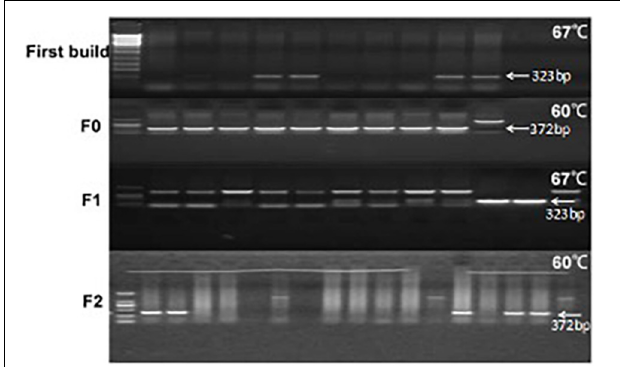
FIGURE 2 | Agarose electrophoresis analysis of PCR amplification products of the galectin-7-encoding gene in the mouse of different generations of TG mice at different annealing temperatures. Each lane was loaded with 5 µ l of PCR products. This is a combination diagram of agarose gel electrophoresis reactions of different individual mice, where F0, F1, and F2 represent the algebra of different mice. In the agarose gel electrophoresis figure, from left to right, the first lane on the left is a marker (DL2000-DNA-marker, with sizes of 100, 250, 500, 750, 1,000, and 2,000 bp, respectively. Second, each lane represents an individual. First built mice 12 mice, F0 has 12 mice, F1 has 10 mice, and F2 had 15 mice. Each individual uses two sets of different primers for PCR amplification, the product sizes are 323 bp and 372 bp, respectively, and the reaction system was 25 µ l as described in the method. When the first band is unclear or the band is too shallow, it uses the second set of primers to detect coincidence. The positive control is the galactin-7 template (cDNA sequence) ligated in the T-vector—the positive control. A number of 4 individuals were tested two times in the F0